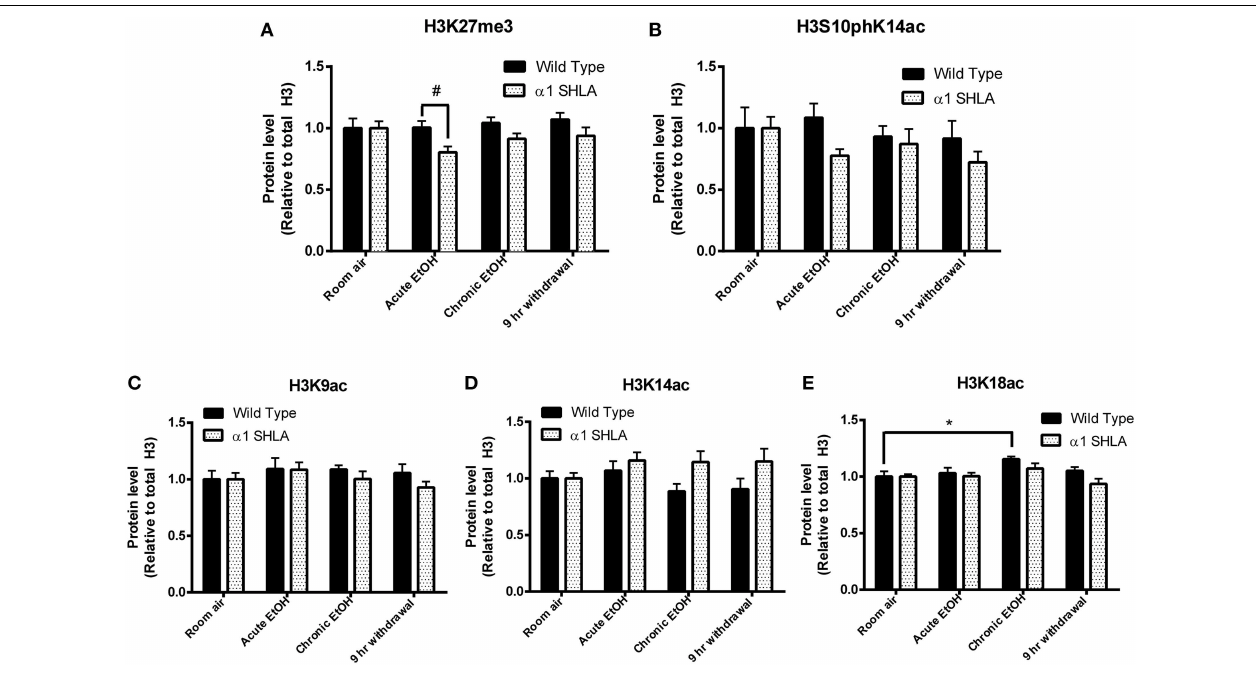
genotype on levels of H3S10pK14ac ( p = 0 . 09 ), (C) no effect on levels of H3K9ac, (D) an effect of genotype on levels of H3K14ac ( p < 0 . 05 ), and (E) an effect of both genotype ( p < 0 . 05 ) and EtOH exposure ( p < 0 . 05 ) on levels of H3K18ac and a significant increase in H3K18ac following CIE in WT mice. * p < 0 . 05 , # p = 0 . 07 , n = 6 /group, data presented as mean ±